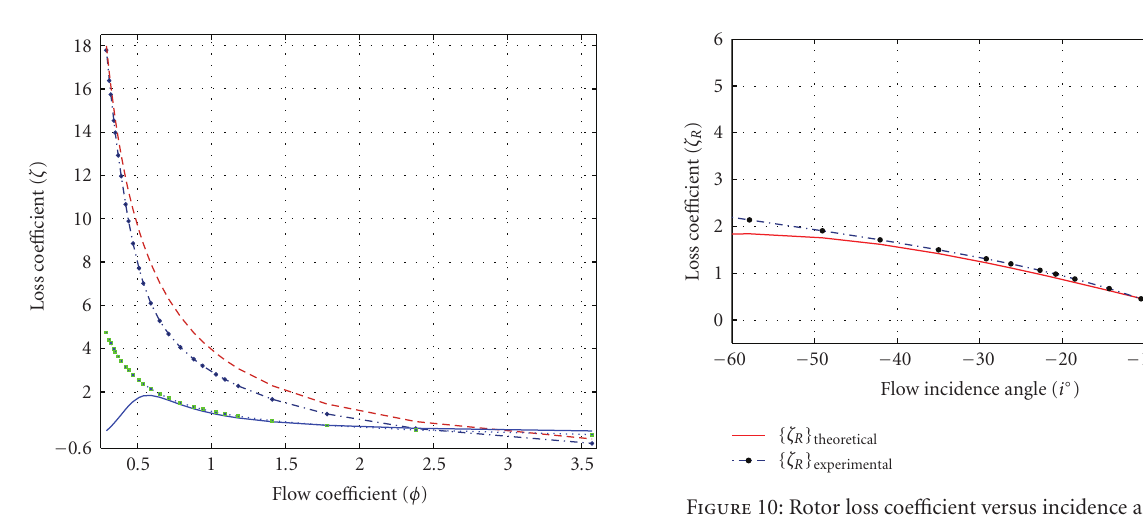
Figure 9: Turbine loss coe ffi cient versus flow coe ffi cient [10].